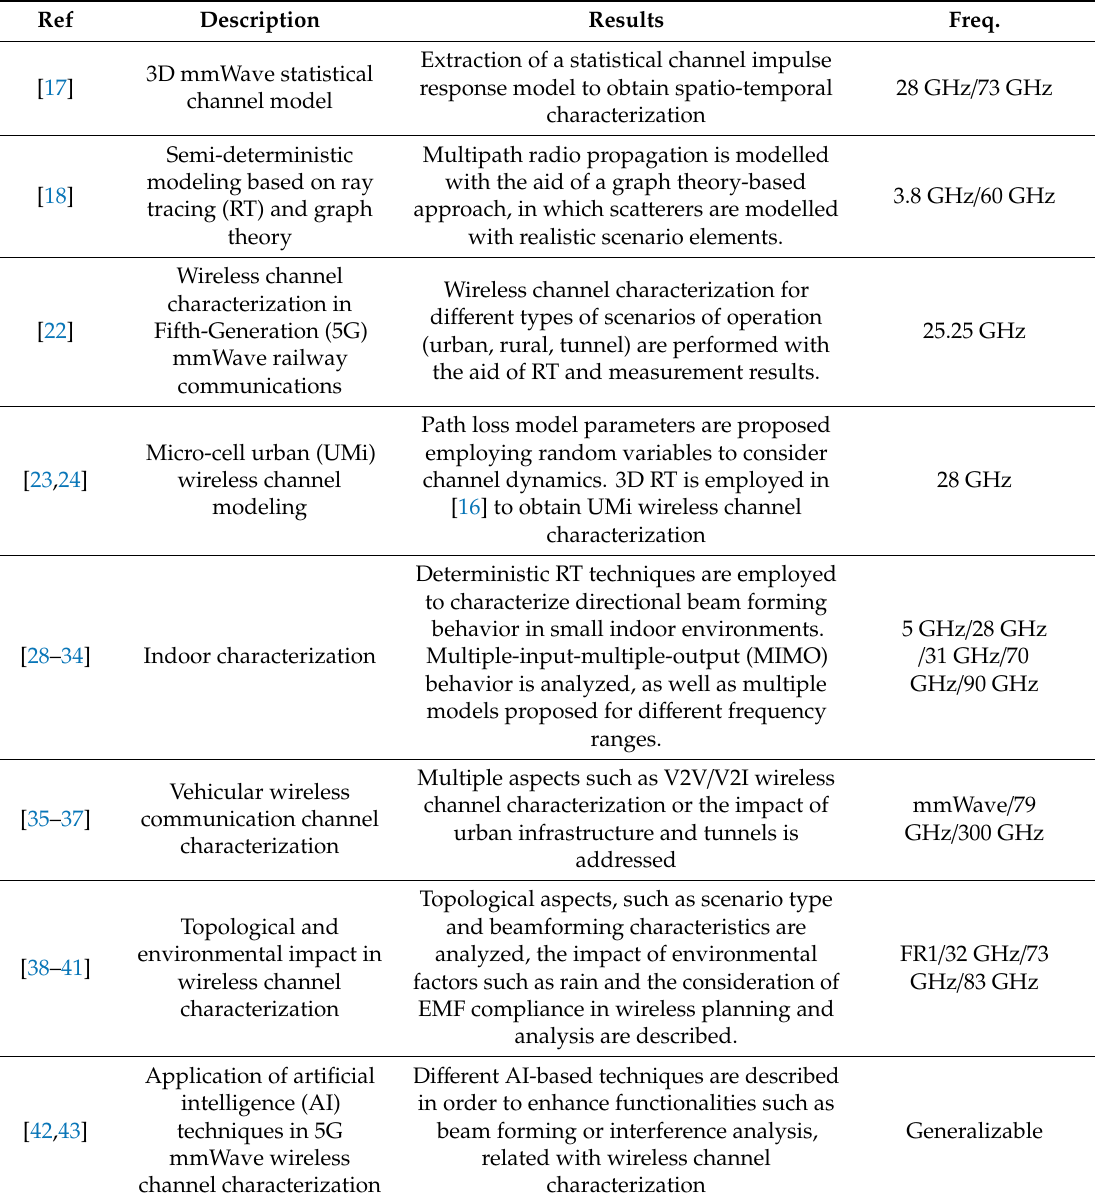
Table 1. Overview of wireless channel characterization